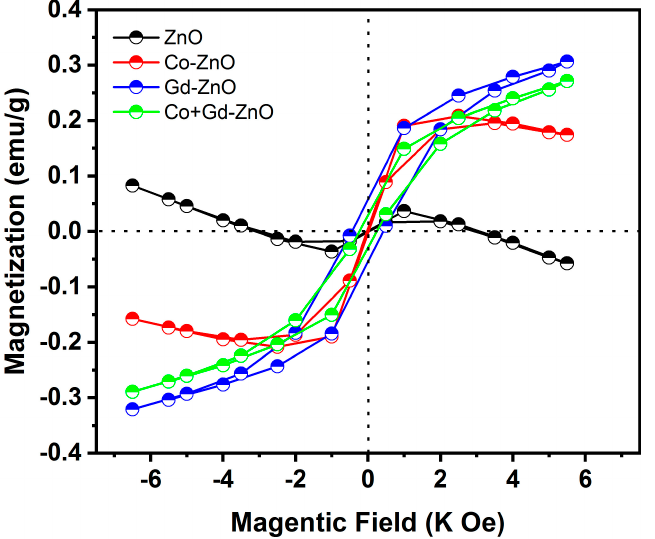
Figure 8. Magnetization curve of pure, Co-doped, Gd-doped, and Co/Gd dual-doped ZnO nanoparticles. Table 4. Parameters of magnetic properties for all the